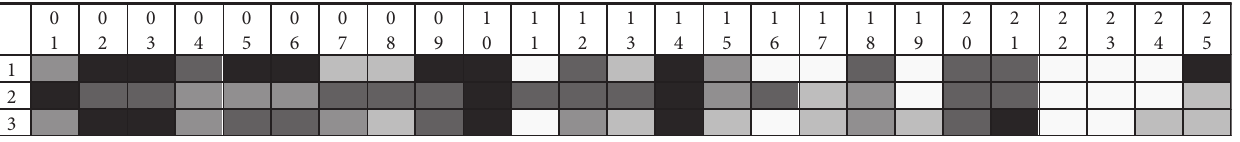
Table 7: Visualization of weighting by experts.